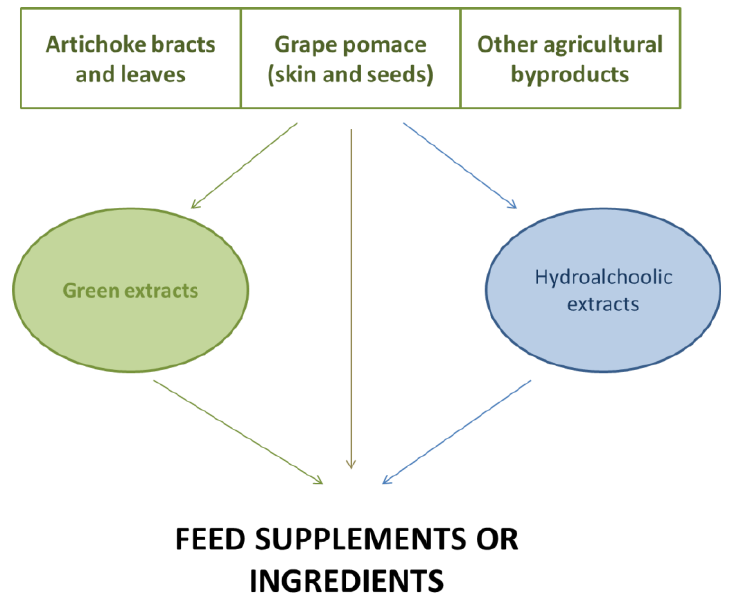
Figure 1. Different options for the production of animal feed supplements.